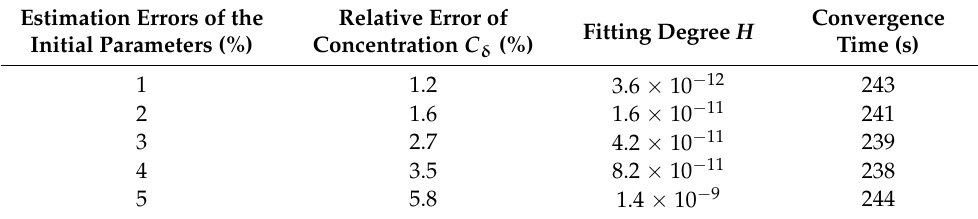
Table 3. Comparison results under the different estimation errors of the initial parameters.